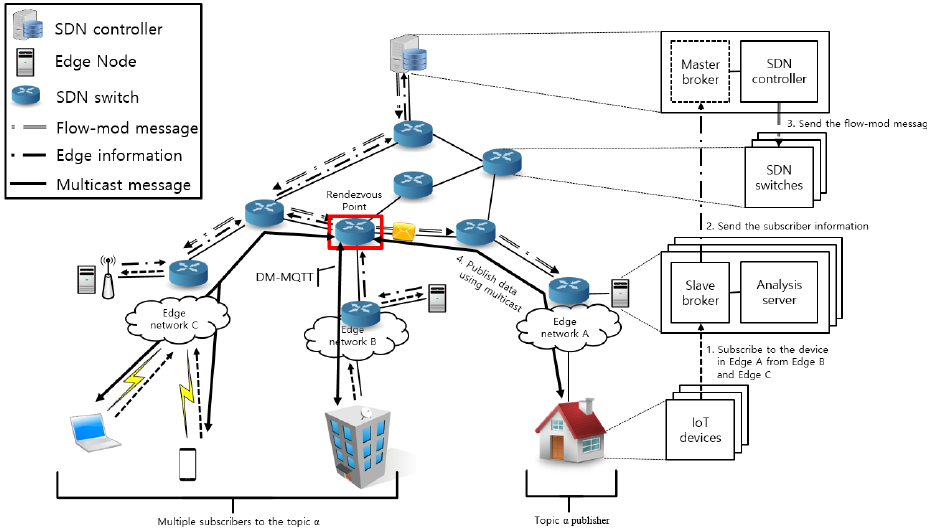
Figure 1. DM-MQTT architecture in edge computing.